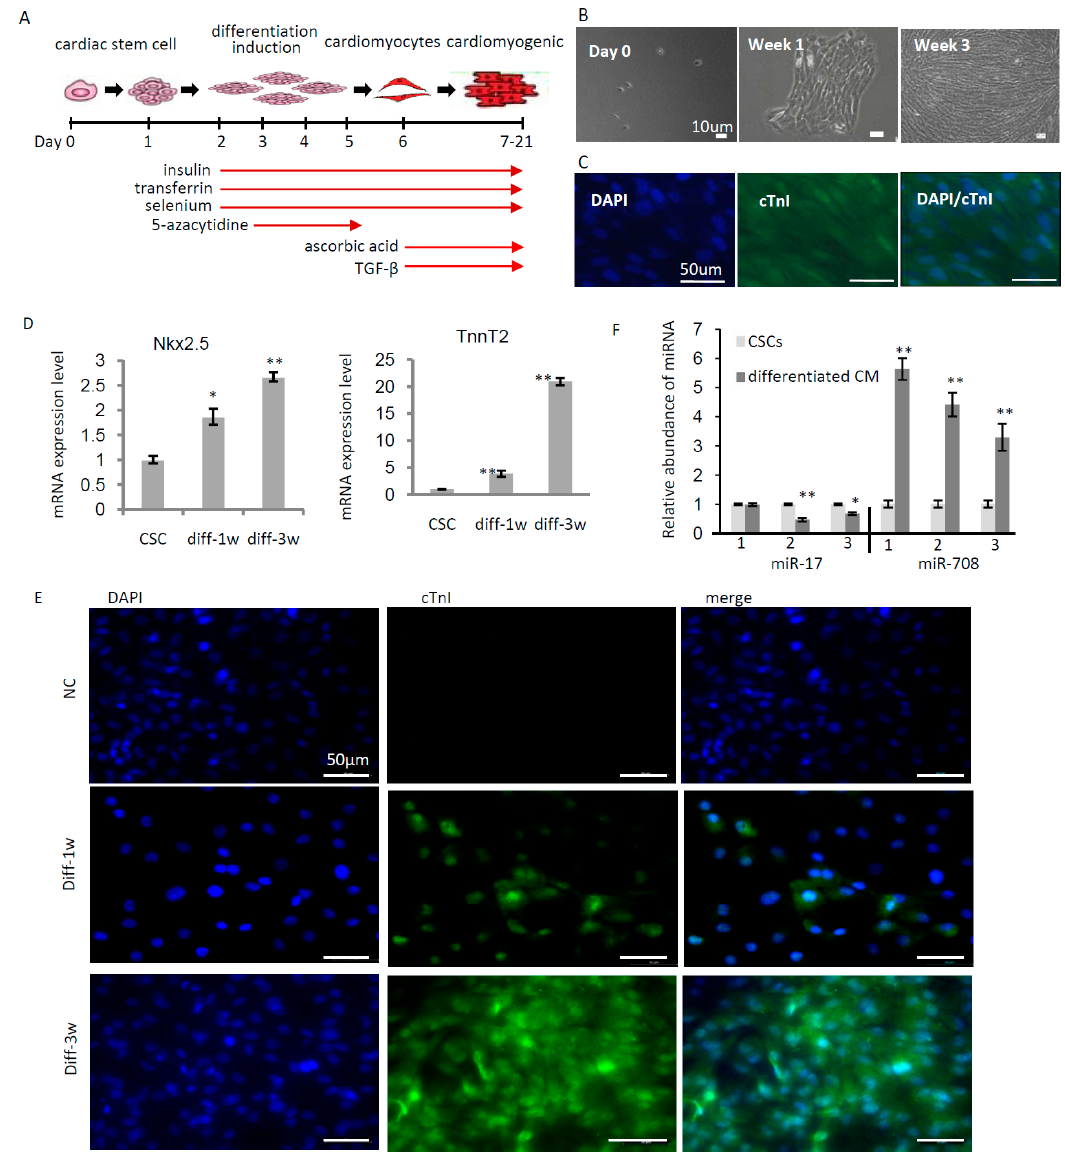
Figure 2. miR-708 was upregulated upon differentiation of cardiac stem/progenitor cells. ( A ) Schematic representation of the procedure for the differentiation induction of cardiac stem/progenitor cells to cardiomyocytes in vitro ; ( B ) Representative photographs showing the differentiation of c-kit(+) cardiac progenitor cells to cardiomyocytes, forming myocardium-like strips in the cell culturing system; ( C ) Immunofluorescence staining of cardiac troponin I (cTnI) in the cardiomyocytes differentiated from cardiac progenitors; ( D ) Quantitative analysis of Troponin T Type 2 (TnnT2) and NK2 transcription factor related, locus 5 (NKX2.5) expression in cardiac stem/progenitor cells and differentiated cells after 1-week and 3-weeks of differentiation; ( E ) Immunofluorescence staining of cTnI in the differentiated cells after 1-week and 3-weeks of differentiation from cardiac progenitors. IgG as negative control (NC) for anti-cTnI; ( F ) A quantitative analysis of miR-17 and miR-708 expression in cardiac stem/progenitor cells and differentiated cells indicating the downregulation of miR-17 and upregulation of miR-708 upon differentiation. diff: differentiation. Data are mean ± SEM ( n = 3). * p < 0.05, ** p < 0.01.